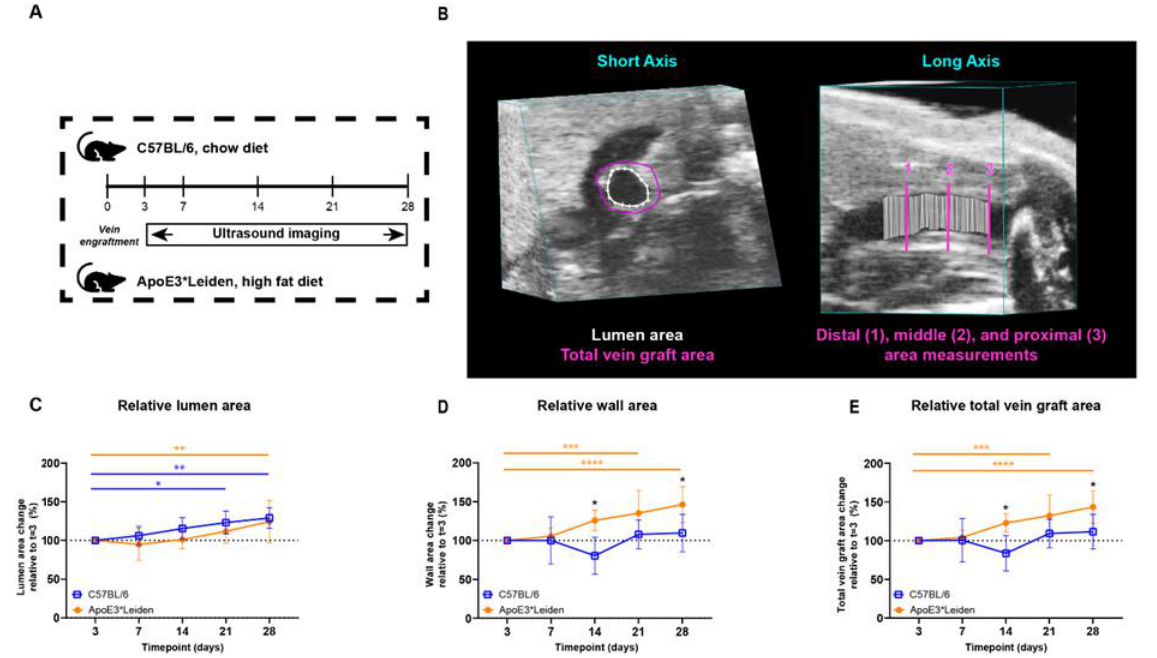
Figure 1. Study design and area measurements of the vein grafts in C57BL/6J and ApoE3*Leiden mice over time. ( A ) C57BL/6J ( n = 7, chow diet) and ApoE3*Leiden mice ( n = 7, high-fat diet) underwent vein graft surgery and were imaged on day 3 and a weekly schedule thereafter during the time course of 28 days. ( B ) Example of an area measurement, three-dimensionally corrected, depicting lumen area (white), total vein graft area (pink), and a long-axis view of the three separate measurement sites. 1 = distal, 2 = middle, 3 = proximal. Wall area is calculated by subtracting the lumen area from the total vein graft area. The total vein graft area is a measure for outward remodeling. ( C – E ) Graphical representations of, respectively, lumen ( C ), wall ( D ), and total vein graft area ( E ), calculated relative to their baseline measurements at t = 3 days post-surgery. Statistics: ANOVA mixed model, corrected for multiple testing; * p < 0.05, ** p < 0.01, *** p < 0.001, **** p < 0.0001.